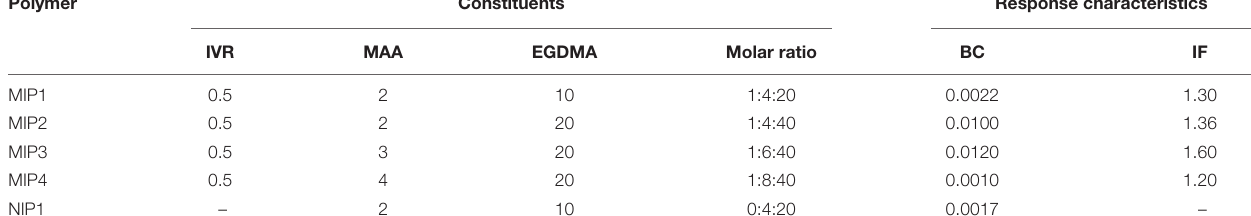
TABLE 1 | The composition of the different non-printed (NIP) and molecularly imprinted (MIP) polymers, binding capacity (BC), imprinting factor (IF), and the mole ratio of IVR, MAA, and EGDMA in about 4 mol of DMSO that was used as a solvent in all ratios. Polymer